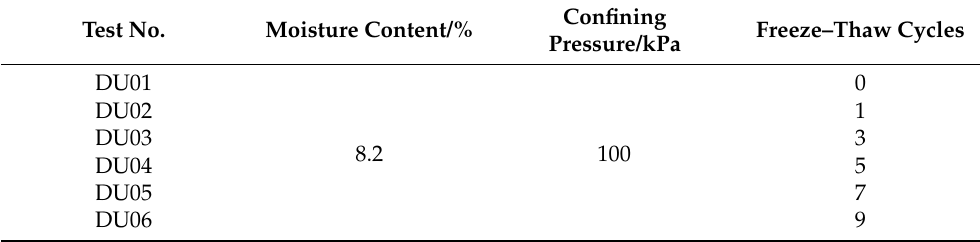
Table 3. Design of dynamic triaxial testing for NSF.